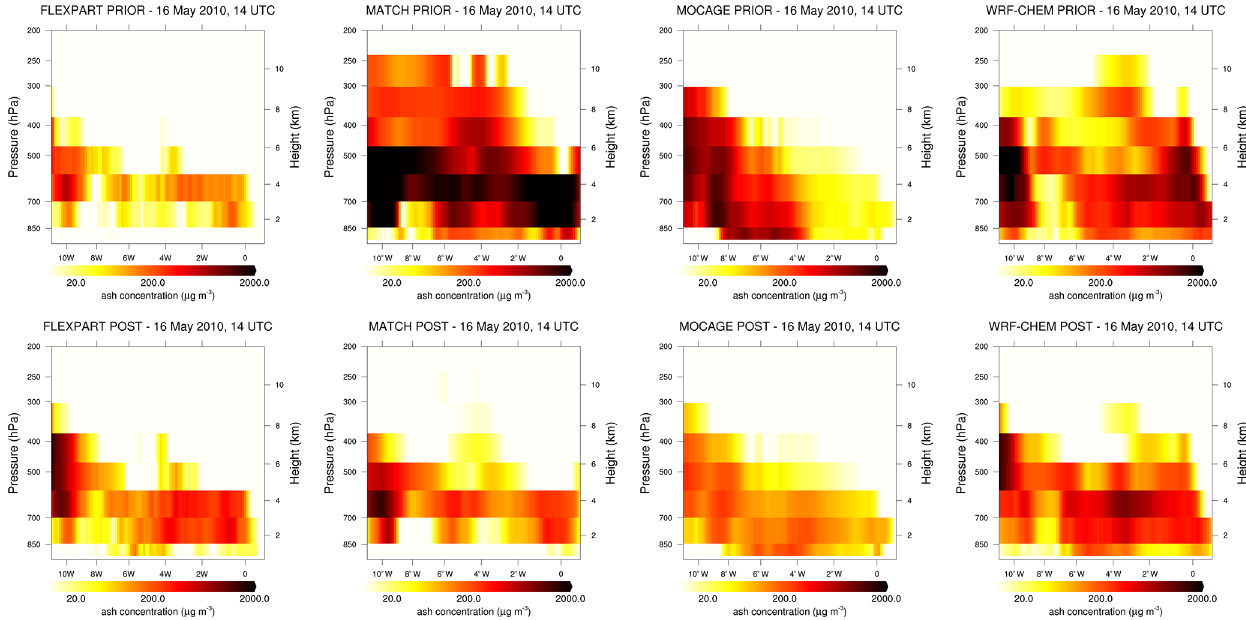
Figure 6. Ash mass concentrations on 16 May 2010 at 14:00UTC for the four models (from left to right: FLEXPART, MATCH, MOCAGE, and WRF-Chem) with a priori source terms (top) and with a best-estimate a posteriori source term (bottom) across the horizontal line shown in Fig.